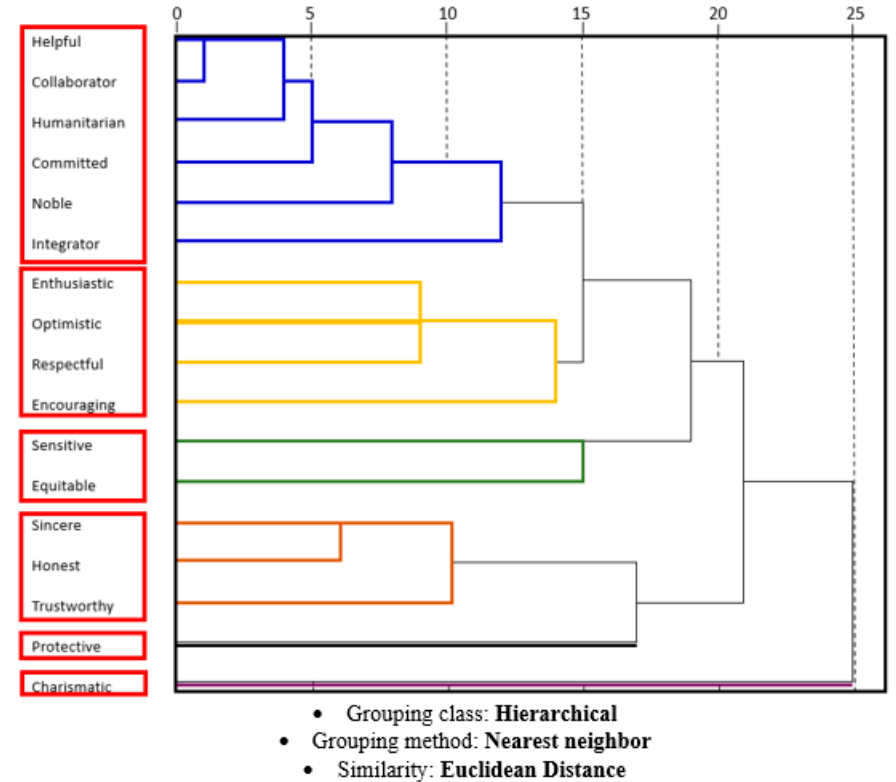
Figure 2. Graphic representation of adjectives grouping.